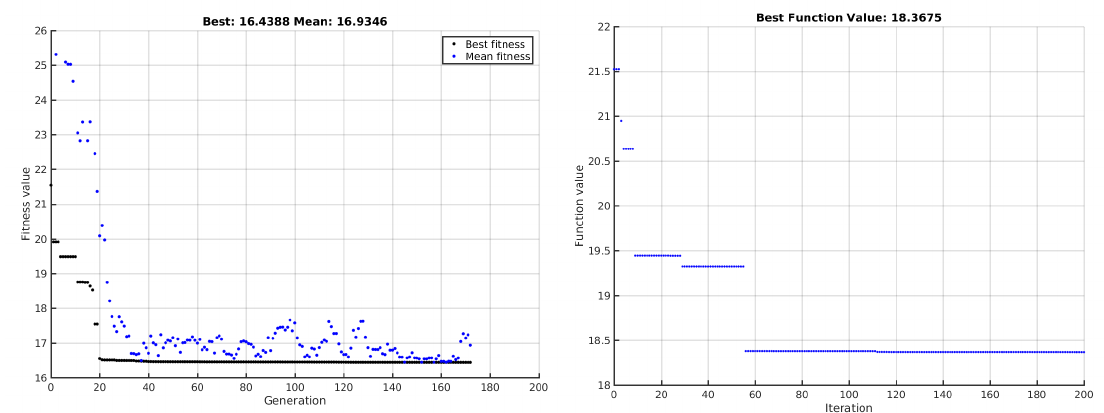
Figure 8. Historical evolution of the best deployment of TWUs when genetic algorithms (GAs) ( left ) and particle swarm optimization (PSO) ( right ) were used.